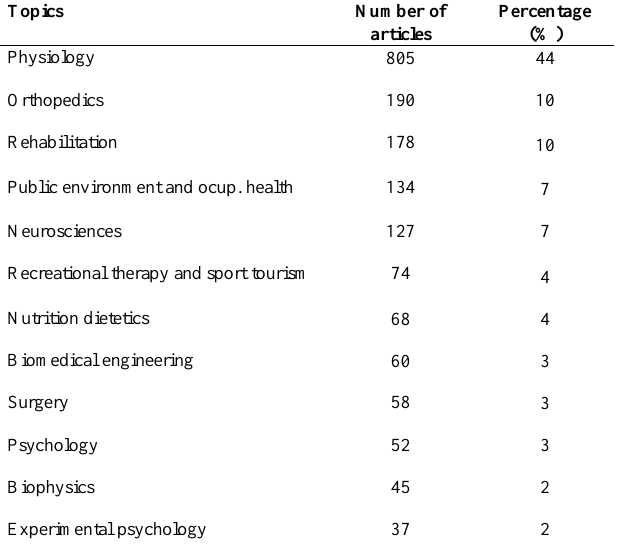
Table 2. Frequency and percentage of the most-studied topics in the sports science in South American countries from 1970 to 2012.